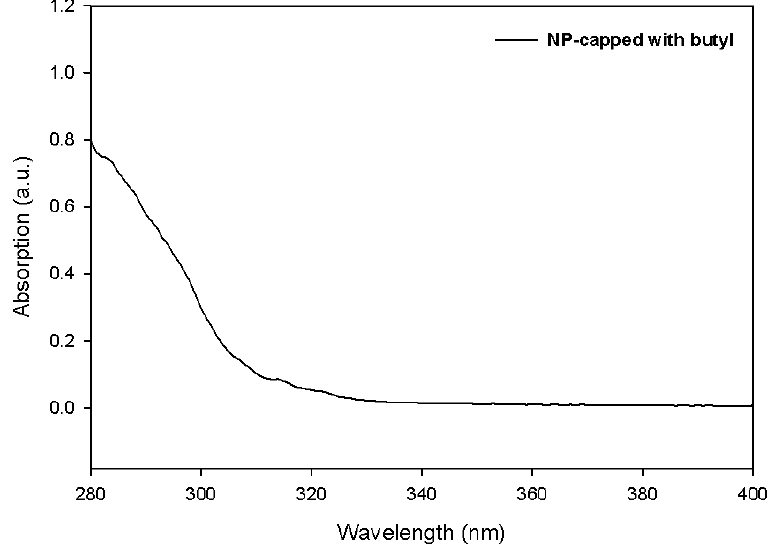
Figure S2: Absorption spectra of Silicon nano-particles capped with butyl in